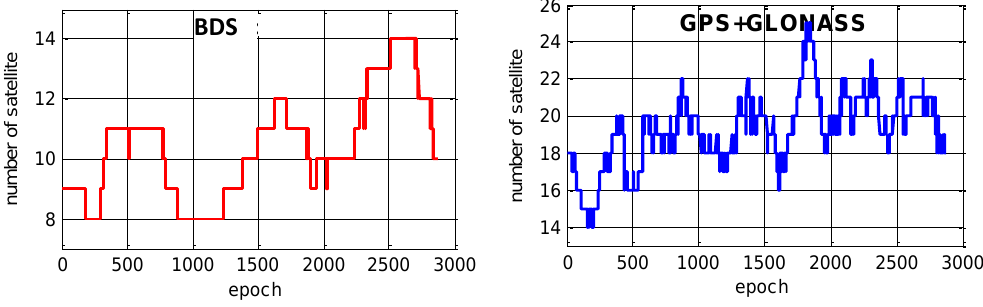
Figure 2. Number of visible satellites of BDS/GPS/GLONASS.